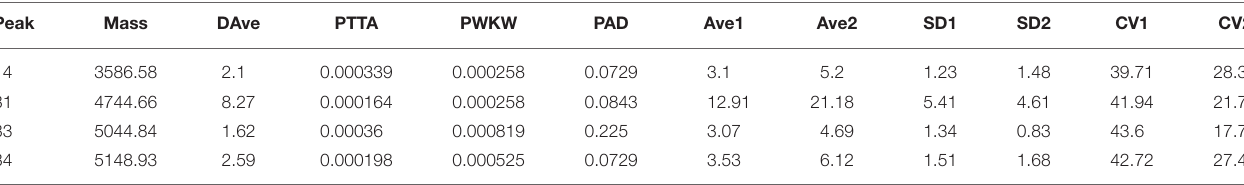
TABLE 4 | ClinProTools peak statistics for the four peaks of interest in both K1 hvKP and non-K1 K. pneumoniae * . Peak